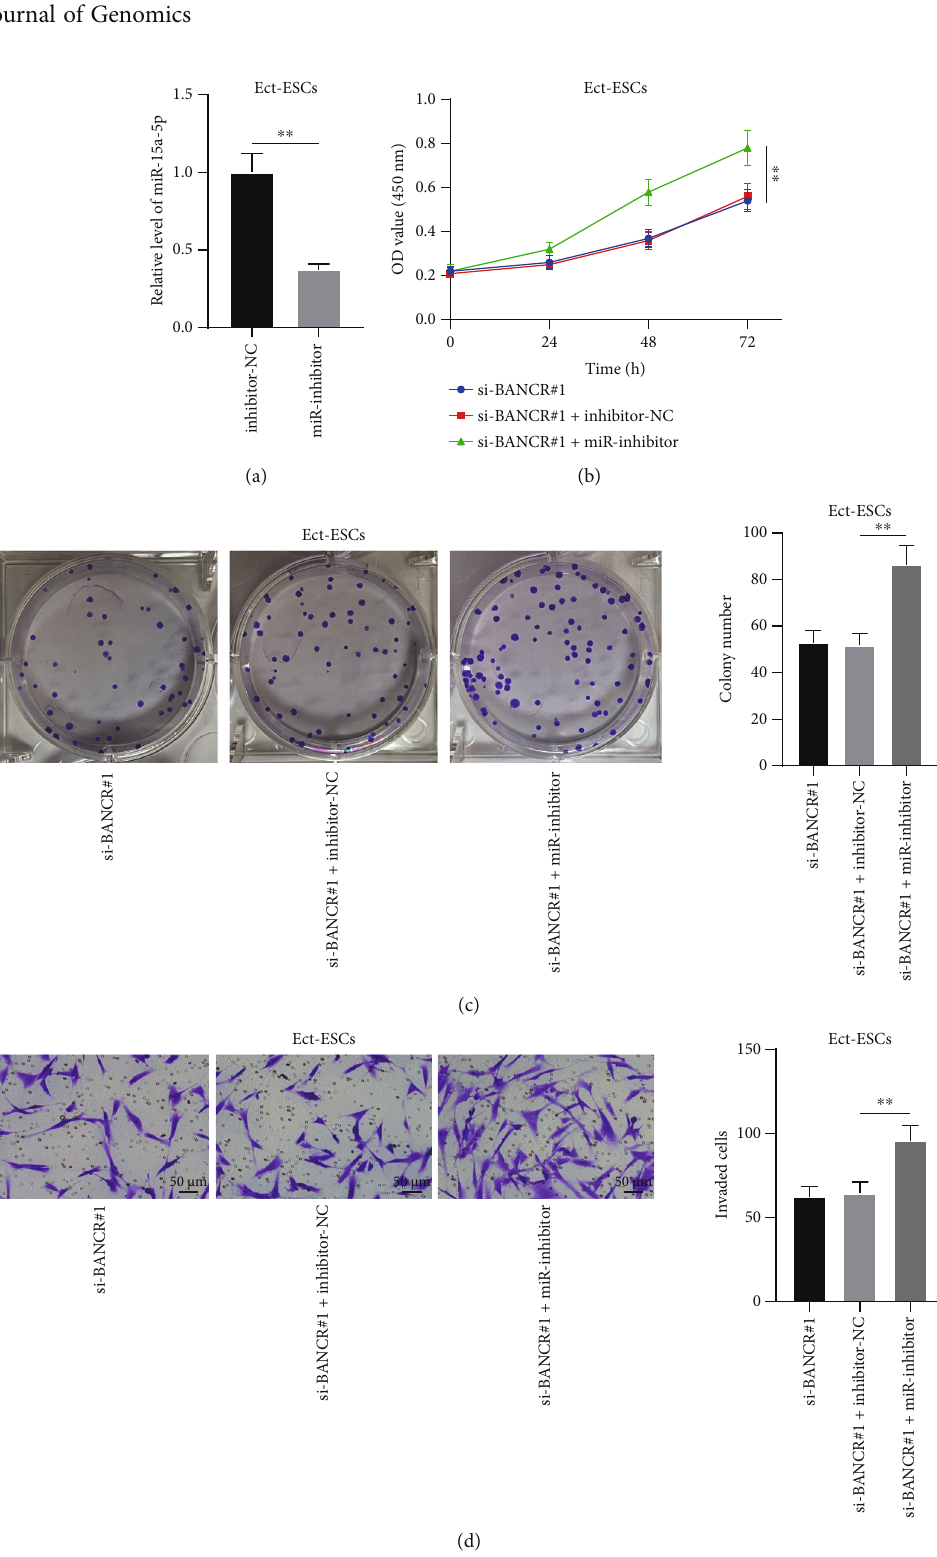
Figure 3: miR-15a-5p downregulation reverses the e ff ects of silencing lncRNA BANCR on inhibiting ectopic endometrial stromal cell proliferation and invasion. Ect-ESCs were transfected with miR-15a-5p inhibitor (miR-inhibitor), with transfection of inhibitor-NC as the negative control. (a) Knockdown e ffi ciency of miR-inhibitor was determined by RT-qPCR; (b) – (c) Proliferation potential of Ect-ESCs was assessed by CCK-8 (b) and colony formation (c) assays; (d) Invasion potential of Ect-ESCs was assessed by transwell assay. Cell experiments were performed thrice independently. Data in fi gures (a) – (d) were formalized as mean ± SD. Data in fi gure (a) were analyzed using the t test, data in fi gure (b) were analyzed using two-way ANOVA, and data in fi gures (c) – (d) were analyzed using one- way ANOVA, followed by Tukey ’ s multiple comparison test. ** P < 0 : 01